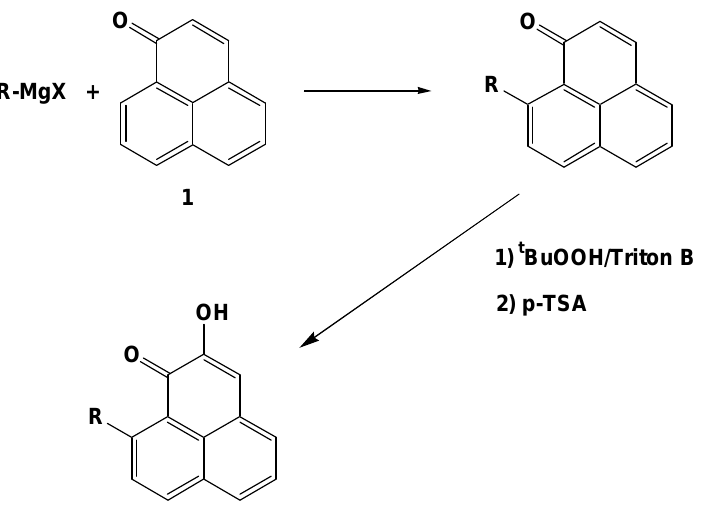
Figure 1. Synthesis of phenylphenalenones.